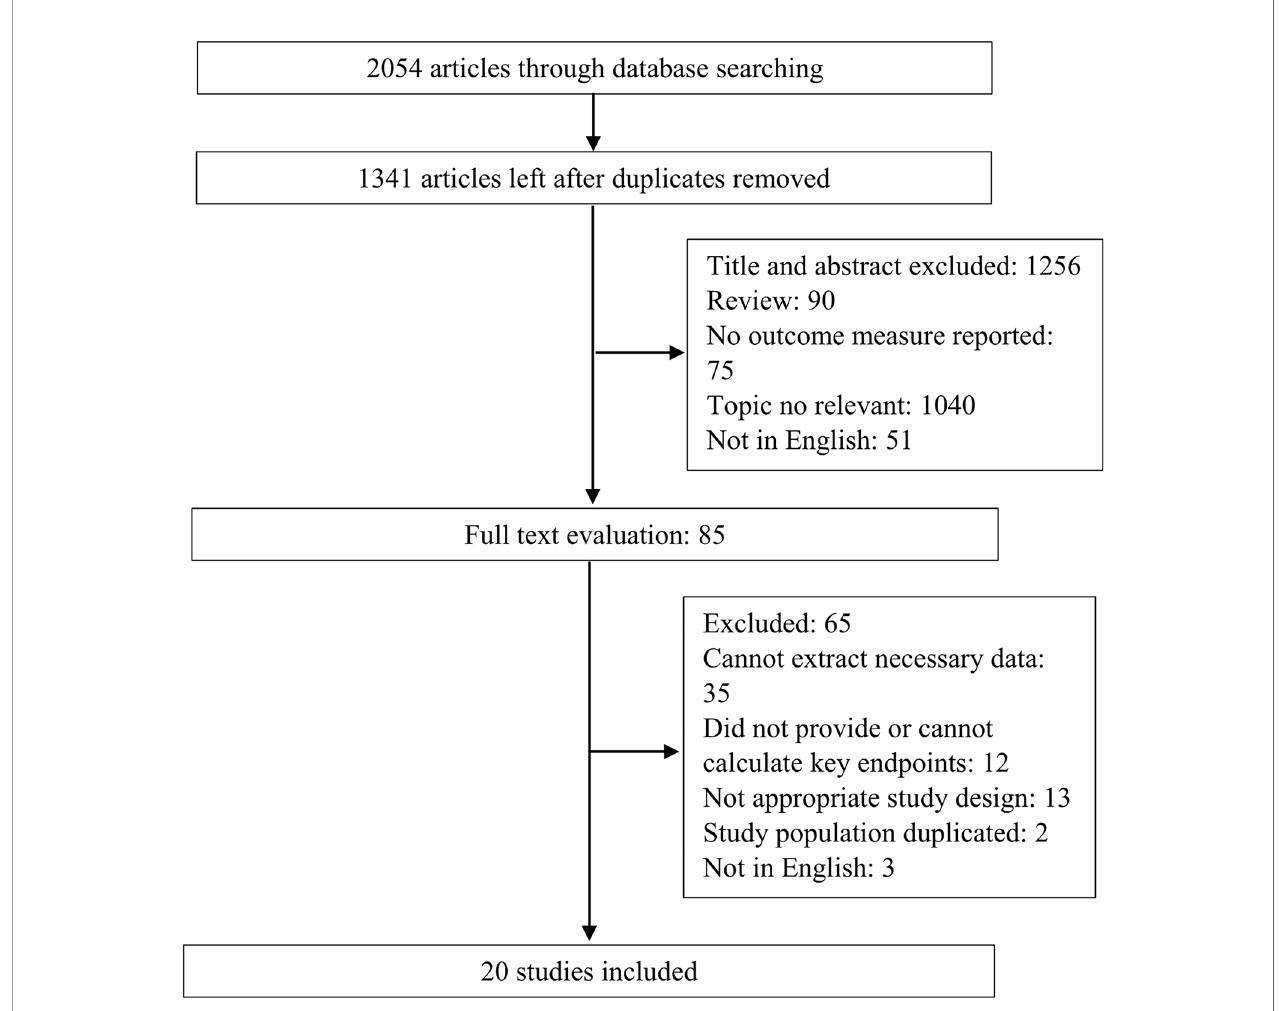
FIGURE 1 | Flowchart of the study selection